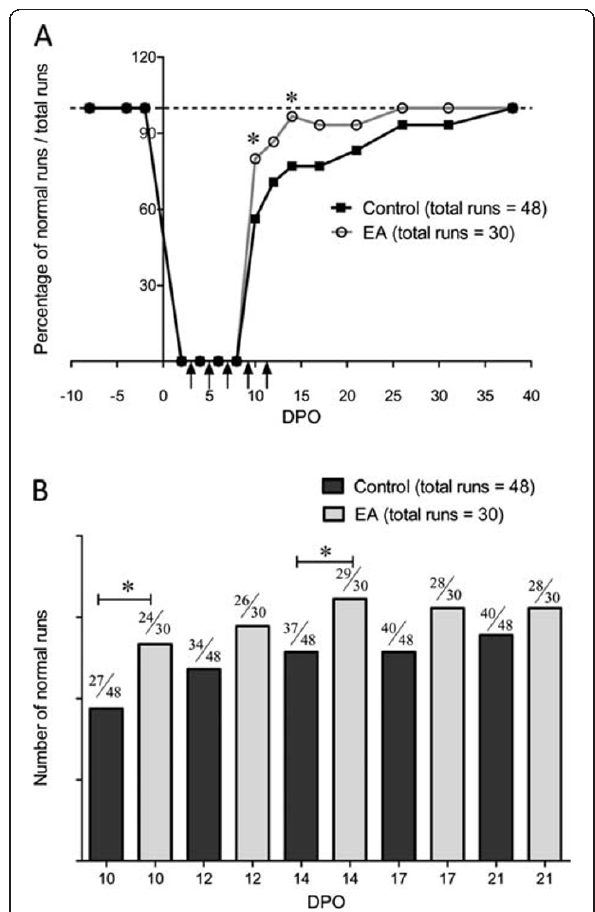
Figure 4 Analysis of hind paw intensity. ( A ) Walking-track analysis of the intensity of the injured hind paw print, expressed in relation to that of the controlateral hind paw print before and after left sciatic nerve crush. Vertical arrows indicate electro-acupuncture (EA) application (group 1). * p<0.05, *** p<0.001 (ANOVA). ( B ) Global analysis of intensity during the plateau phase (10 to 26 DPO) shows an overall significant increase in paw print intensity following electro-acupuncture. * p<0.05, U